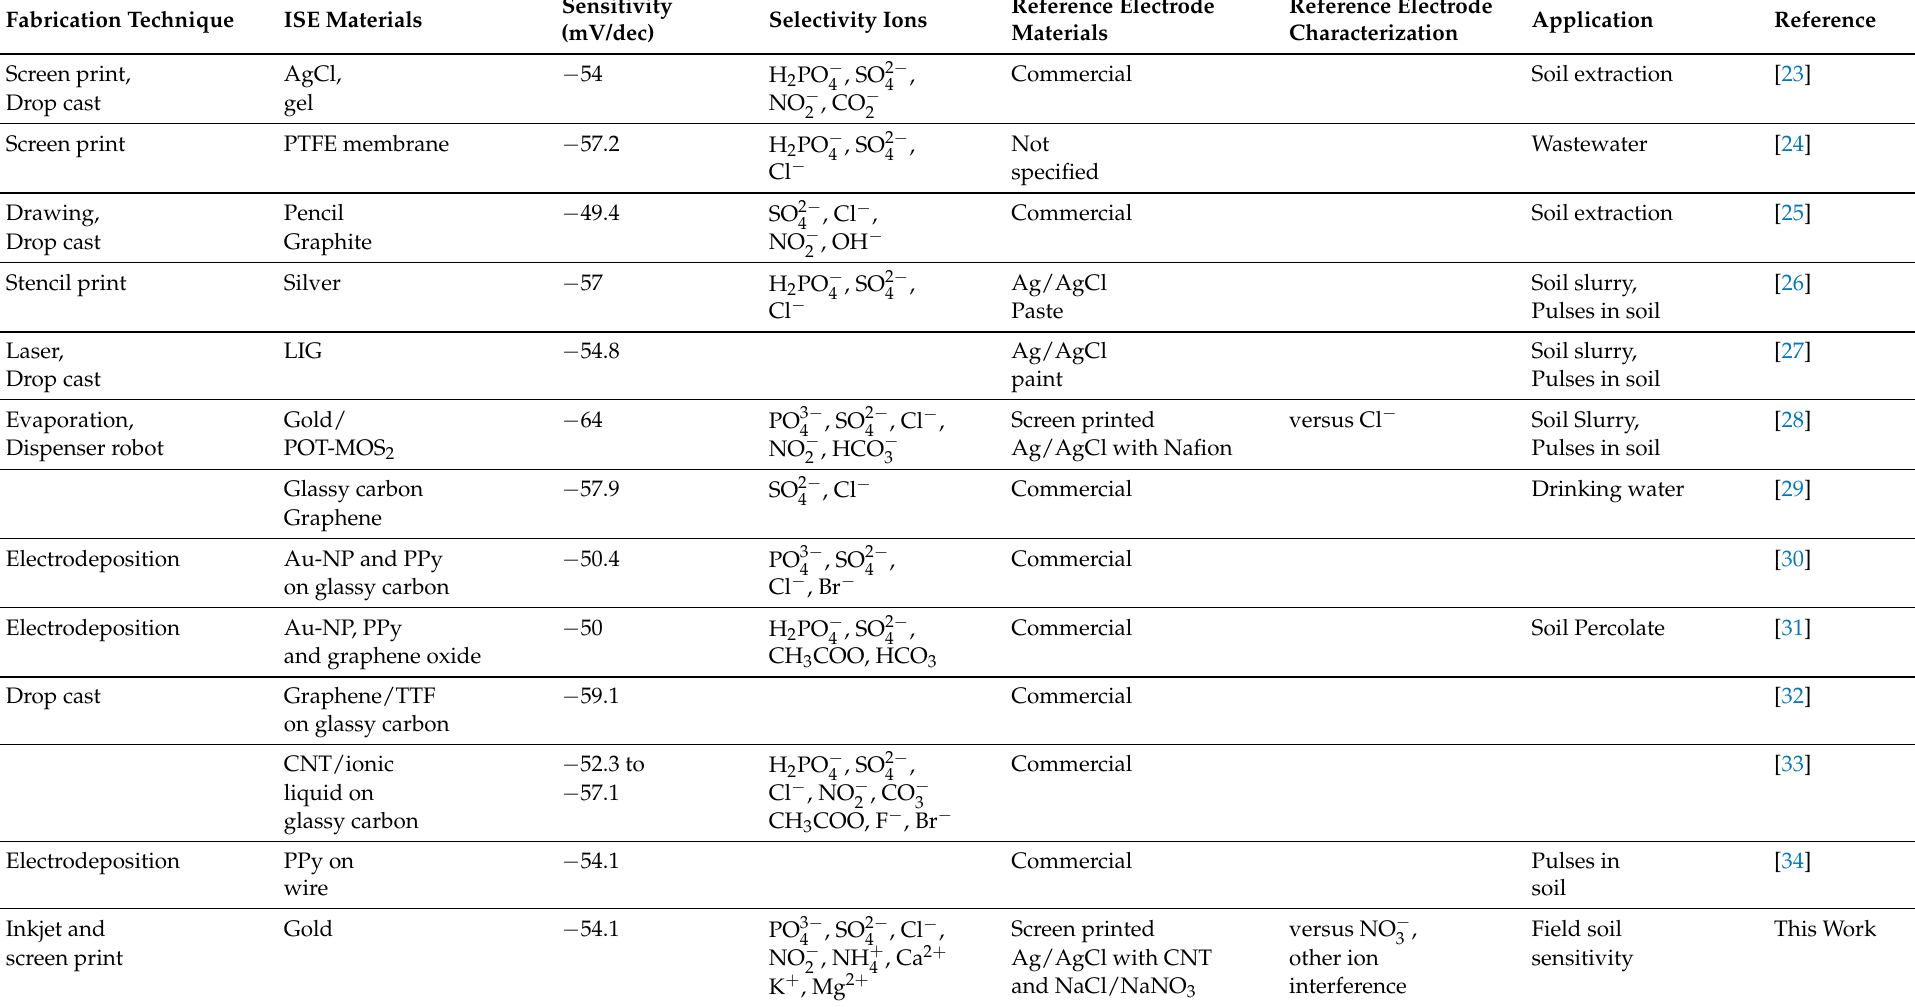
Table 1. Comparison of sensitivity, selectivity, and reference electrodes for nitrate-selective potentiometric